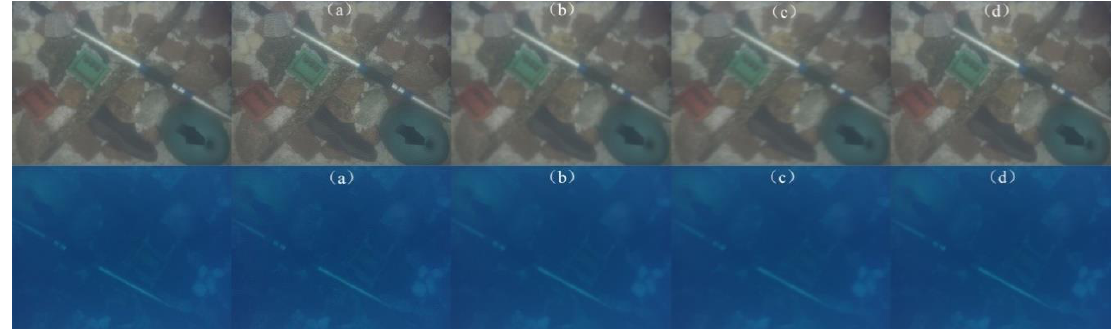
Figure 9. Sample image, restoration and reconstruction results (size 3630 × 2723 pixels) of Chlorophyll (upper row): ( a ) result of VDSR; ( b ) result of Zhang’s method; ( c ) result of PIV − RR; ( d ) result of the proposed method, and that of Deep blue (bottom row): ( a ) result of VDSR; ( b ) result of Zhang’s method; ( c ) result of PIV − RR; ( d ) result of the proposed method Table 10. Evaluation results and running time (min).